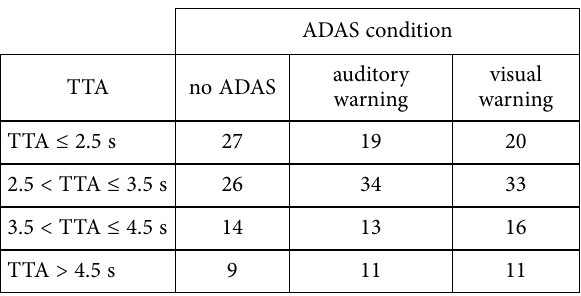
Figure 4. Effect of condition on the variable SRT: a – “crossing condition”; b – “ADAS condition” Table 2. Collected vehicle–pedestrian interactions under different ADAS